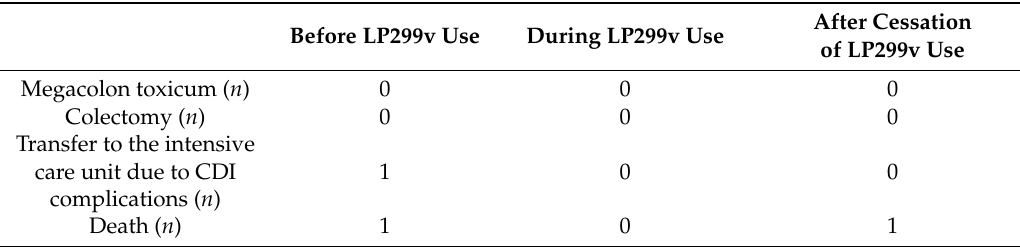
Table 5. Severe Clostridium difficile infections in periods before, during and after cessation of LP299v administration ( n = 3). The above-mentioned periods lasted twelve months.